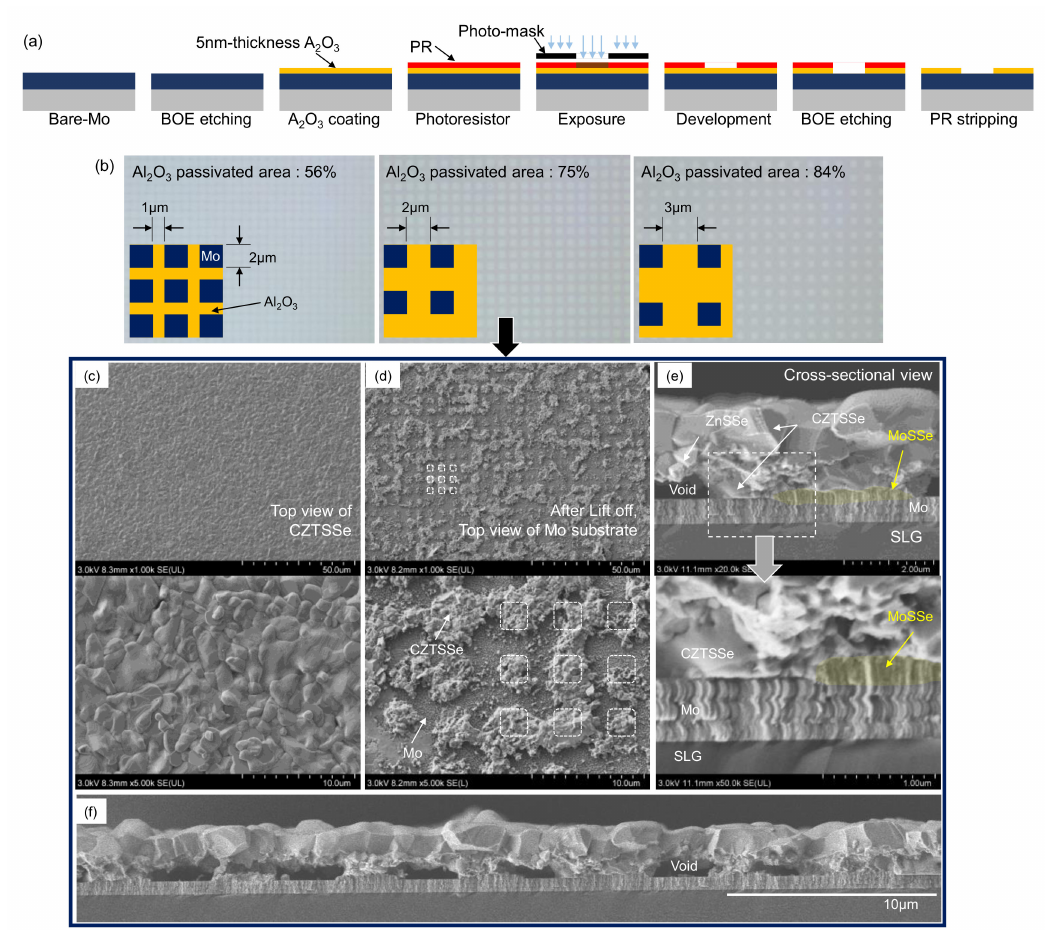
Figure 1. ( a ) Sequence of Al 2 O 3 dot patterning by the photolithography process. ( b ) Photographs of the dot-patterned Al 2 O 3 / Mo substrate and its photo-mask pattern (Al 2 O 3 passivated ratio is 56, 75, and 84%, respectively). FESEM images of ( c ) top view, ( d ) top view of Mo substrate after lifted-o ff , and ( e ) and ( f ) cross-sectional view of a sample with a passivation area of 75%. Using a series of 5-nm-Al 2 O 3 coated Mo substrates, the CZTSSe solar cells were fabricated